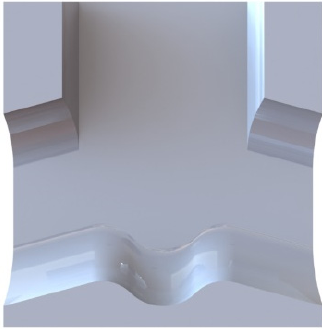
Figure 1. The structures of SEN.